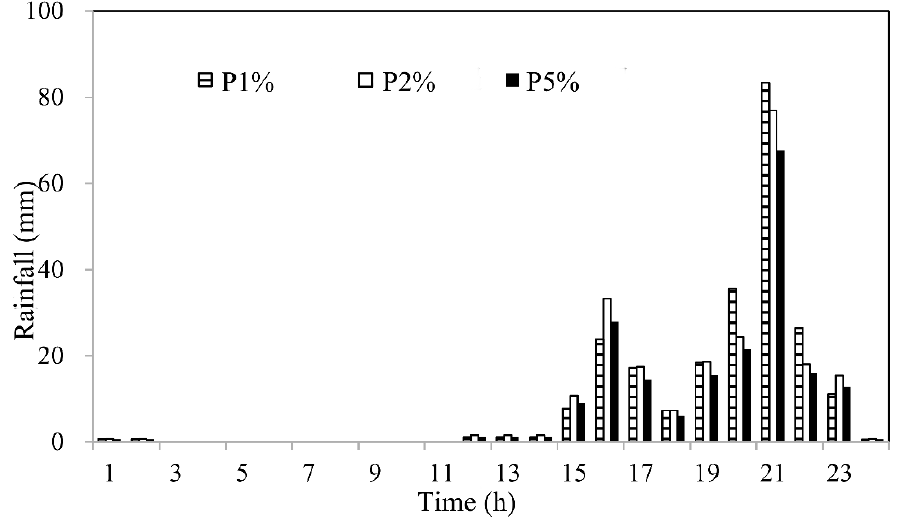
Figure 4. Time distribution diagram of a typical rainfall process.